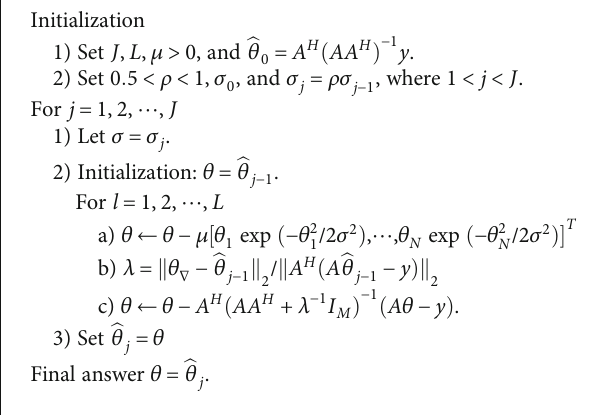
Algorithm 1:The ReSL0 algorithm.